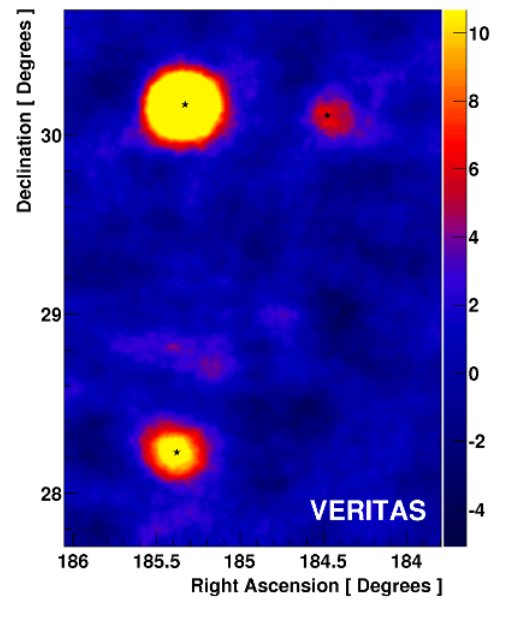
Figure 4. Significance map showing three blazars in a single VERITAS field of view. 1ES 1218 + 304 (upper left) is an HBL, while 1ES 1215 + 303 (upper right) and W Comae are lower- frequency- peaked BL Lacs. The color scale (shown on the right) gives the significance of detection. Note that the apparent exten- sions of the sources are due to saturation on the color scale; each blazar actually appears point-like at TeV energies. (Figure from